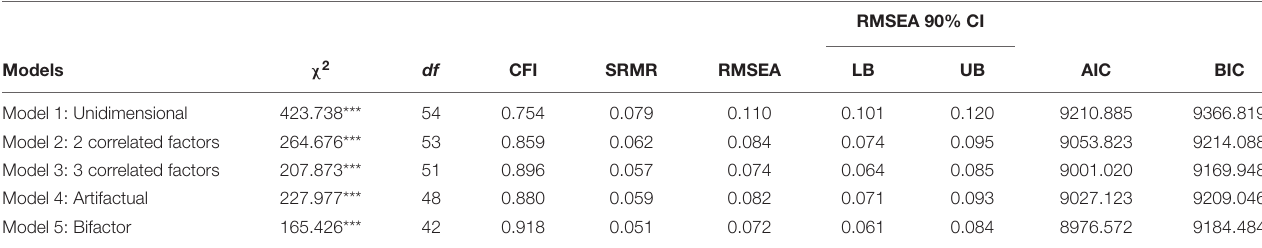
TABLE 1 | Fit statistics for the tested models of the 12-item General Health Questionnaire (GHQ-12), N = 562.